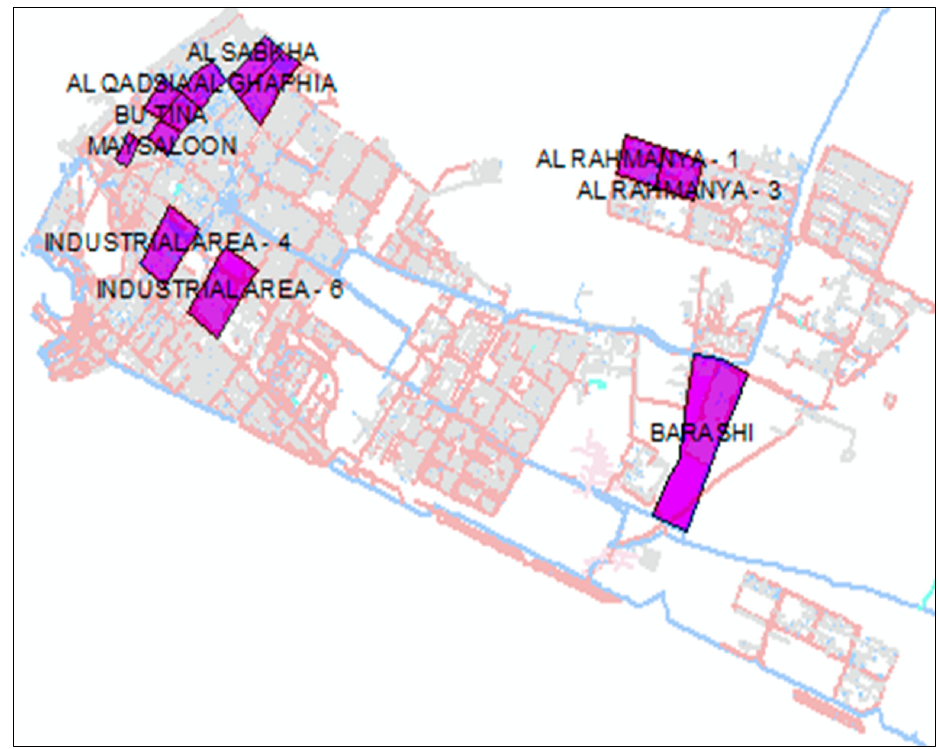
Figure 1. Studied